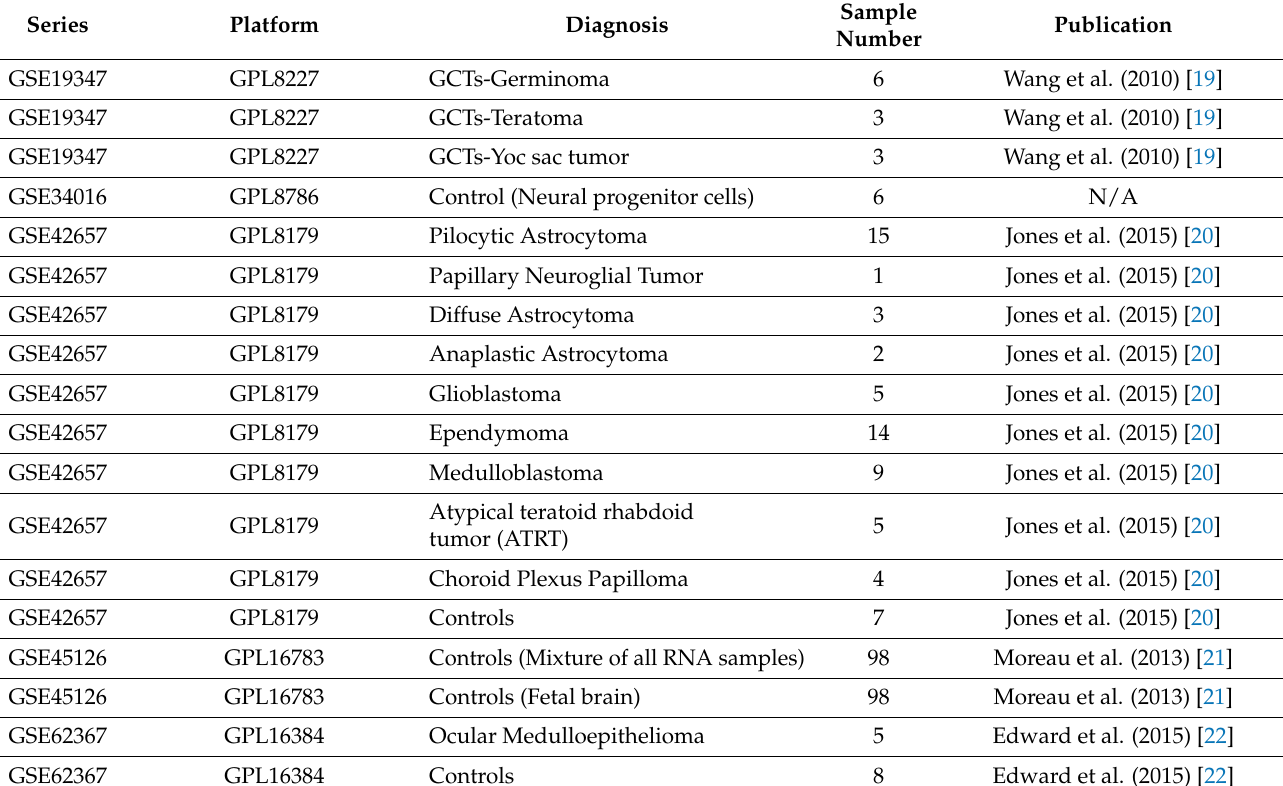
Table 1. Summary of the microarray experiments (data series) used in the present study (Legend: GCTs: Intracranial pediatric germ cell